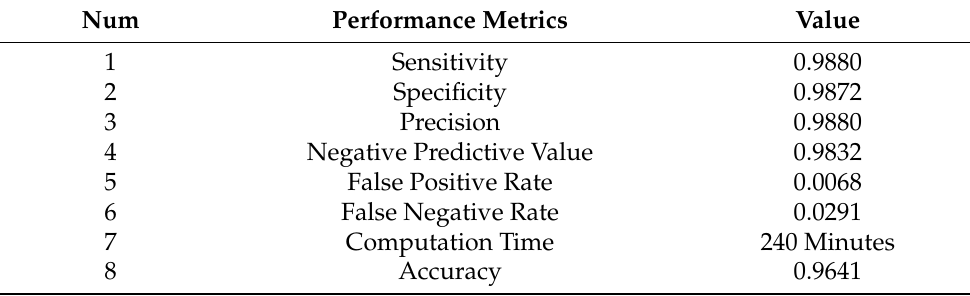
Table 2. The Performance Metrics of Suggested Detection